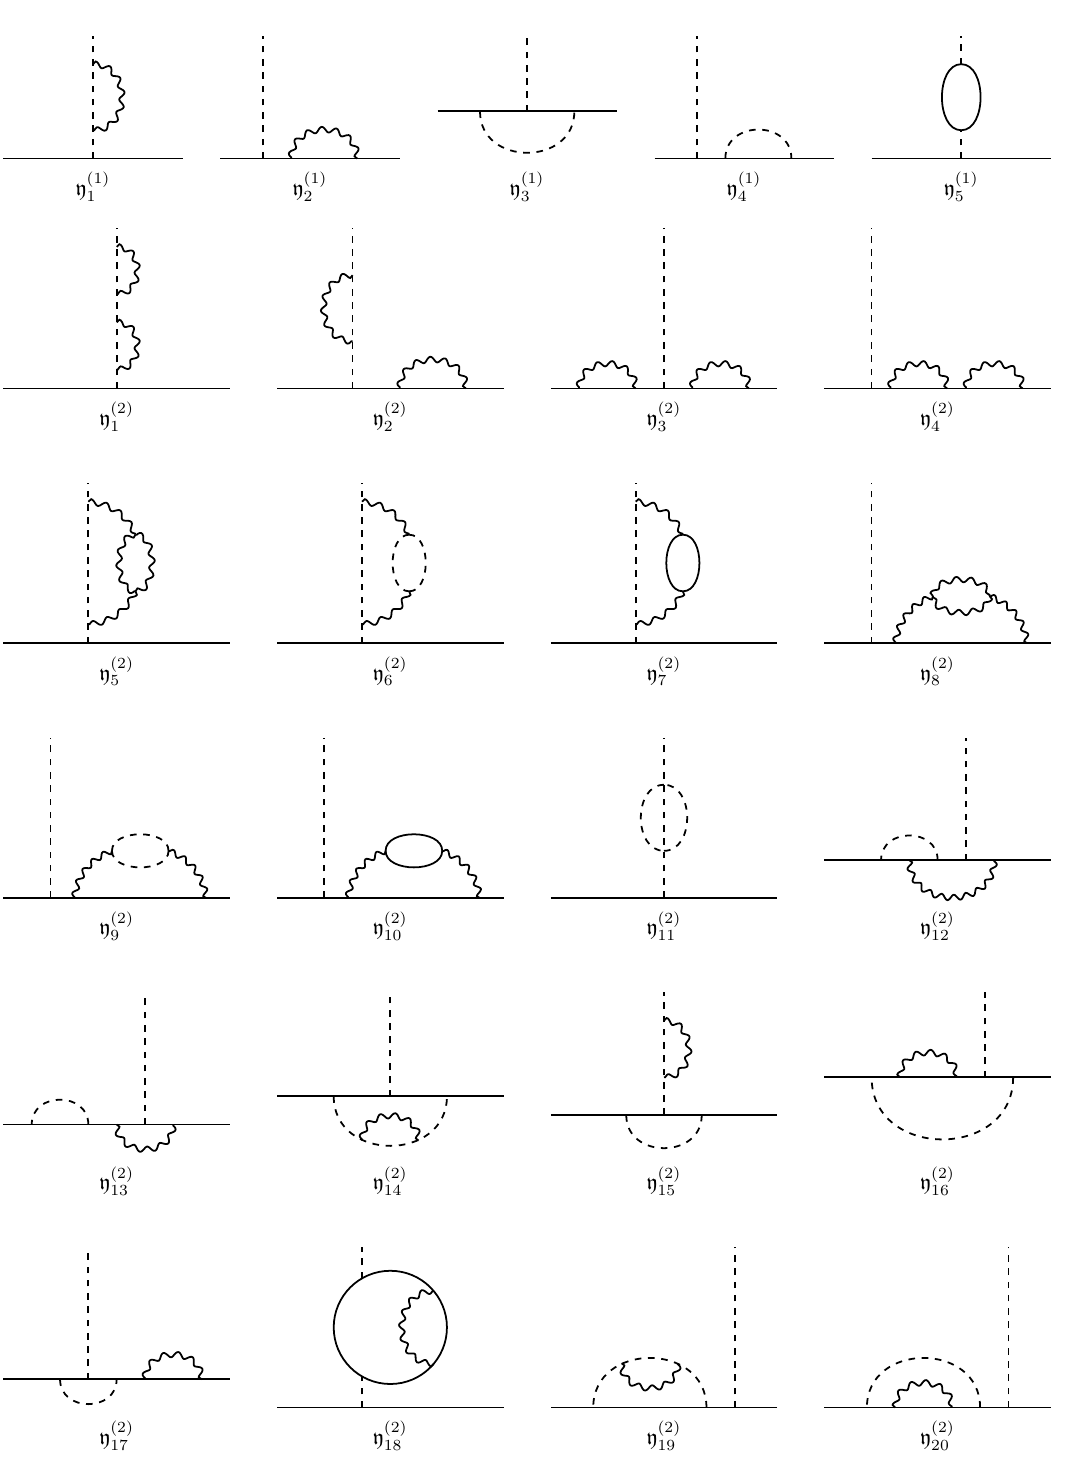
Figure 3 . Graph representation of the TSs appearing in the Yukawa (cid:12) -function, (cid:12) ( ‘ ) 2-loop orders.